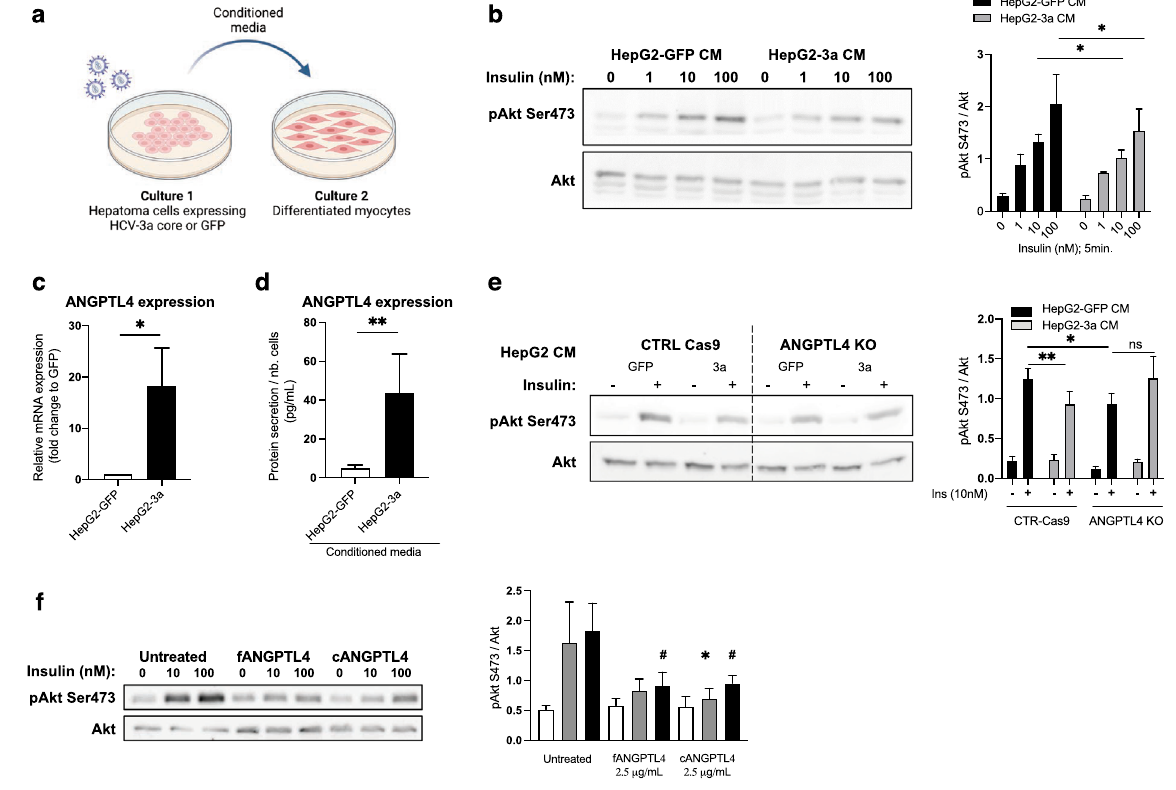
Figure 3. ANGPTL4 is a driver of muscle IR. ( a ) Differentiated C2C12 cells were treated for 24 h with CM of HepG2 cells transduced with either GFP or HCV ‐ 3a core expressing lentivectors before being stimulated with insulin (1, 10 or 100 nM for 5 min) (created with BioRender.com). ( b ) Representative immunoblots and quantification of pAkt Ser473 and Akt total expression in C2C12 cells. ( c ) ANGPTL4 mRNA expression and ( d ) ANGPTL4 secretory levels in HCV genotype 3a core-expressing HepG2 cells. ( e ) Representative immunoblots and quantification of pAkt Ser473 and total Akt expression of C2C12 cells treated with CM from non-edited (CTRL-Cas9) and edited ( ANGPTL4 KO) HepG2 cells transduced with GFP or HCV-3a core. * p < 0.05 and ** p < 0.01. ( f ) Representative immunoblots and quantification of pAkt Ser473 and total Akt expression in human differentiated myocytes treated with different forms of human recombinant ANGPTL4 (2.5 µg/mL) for 24 h. Comparisons are represented as *insulin 10 nM and #insulin 100 nM. * or # p <